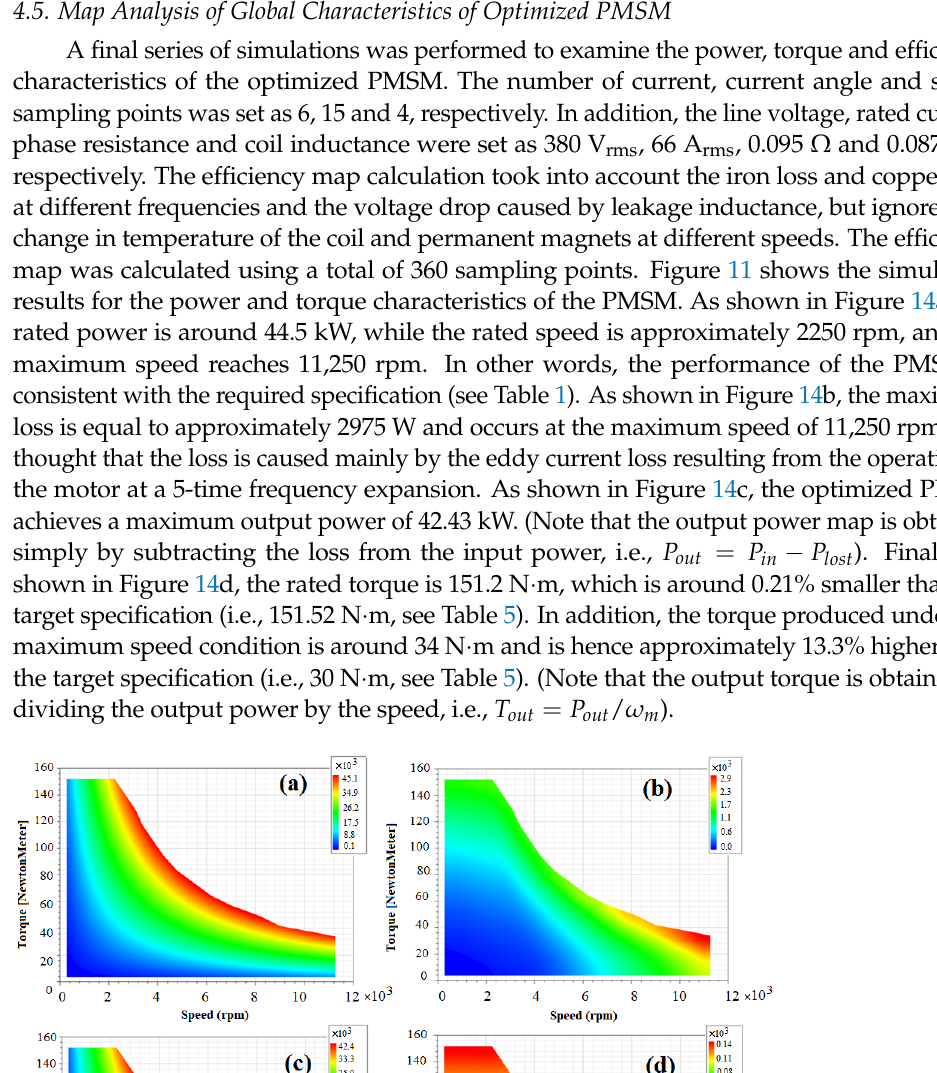
Figure 13. Simulation results for ( a ) induced voltage and ( b ) the demagnetization curve of a perma- nent magnet.